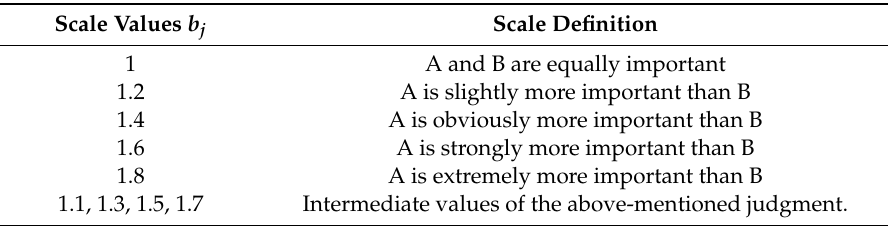
Table 1. The meanings of scale values.